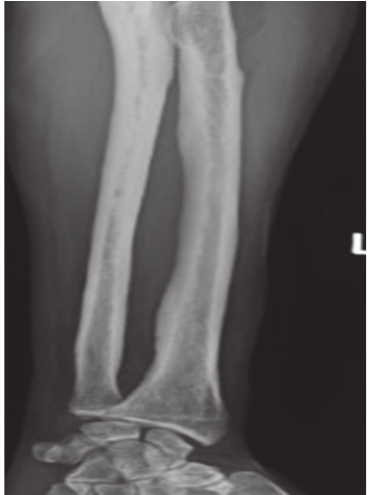
Figure 3: Marked cortical thickening of the radius and